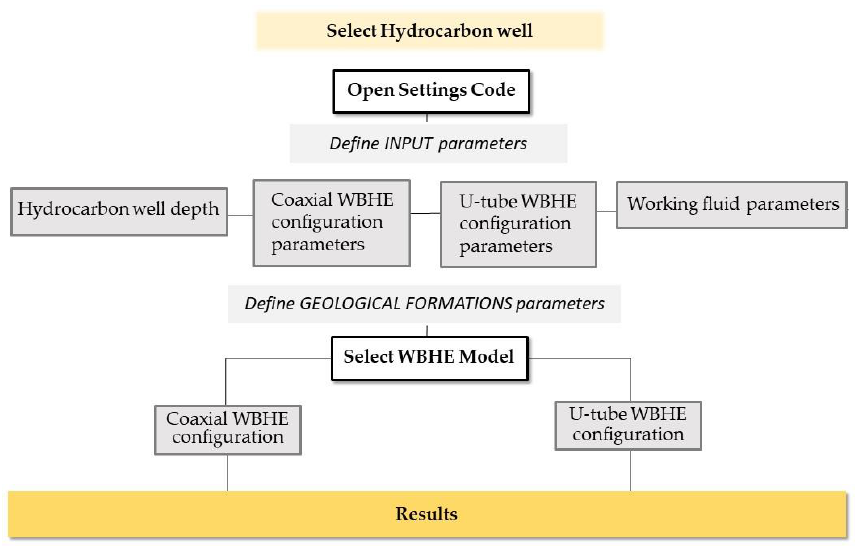
Figure 5. Python codes simplified research flowchart.